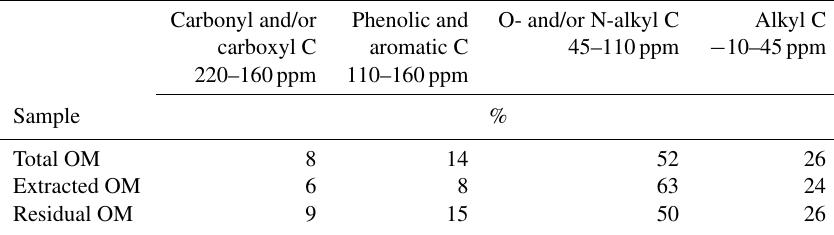
Table 2. Distribution of C species in total, NaF–NaOH-extractable, and residual organic matter of the heavy fraction of the mineral topsoil layer (0–5cm depth) at Hainich (Cambisol, beech) as revealed by CPMAS- 13